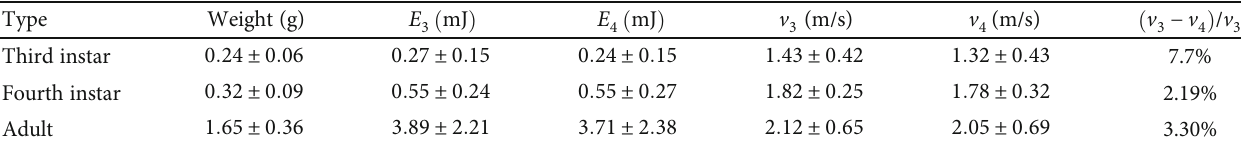
Table 2: Mean velocity and energy of tested L. migratoria at T 3 and T 4 moments. Type listed in Table 2. Based on Equation (2), elastic param- 3.3. Hind Leg Length of Tested Locusts. The tibiae length of eter K values of all tested jumps were calculated with hind legs was signi fi cantly a ff ected by L. migratoria instar known kinematic data and angle data. Elastic parameter ( F 2 , 80 = 24 : 4218 ; P < 0 : 001 ). The tibiae length of adults was K was signi fi cantly a ff ected by the insect instars signi fi cantly longer than that of fourth and third instars ( F 2 , 80 = 5 : 2980 ; P < 0 : 05 ), and K of tested adult locust (Figure S3a, in supplementary materials attached). The femur length of hind legs was signi fi cantly a ff ected by L. jumps was signi fi cantly higher than that of fourth instar migratoria instar ( F 2 , 80 = 18 : 3199 ; P < 0 : 001 ). This femur and third instar locust jumps (Figures 3(c) and 3(d)).